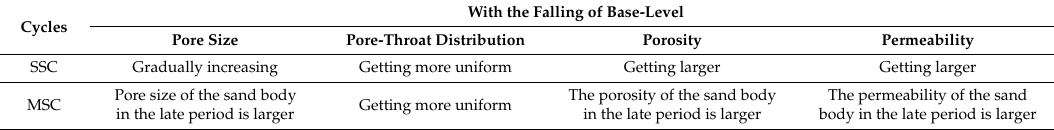
Table 2. Impacts of the base-level cycle on pore structure of mouth